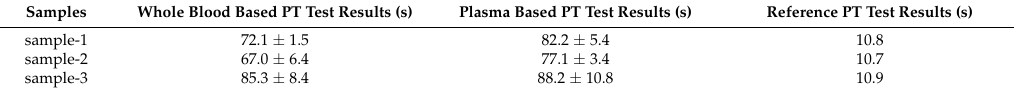
Figure 10. Three samples were used to perform PT measurements based on whole blood and plasma. Table 1. PT test results comparison (Mean ± SD were provided for QCM based test results).